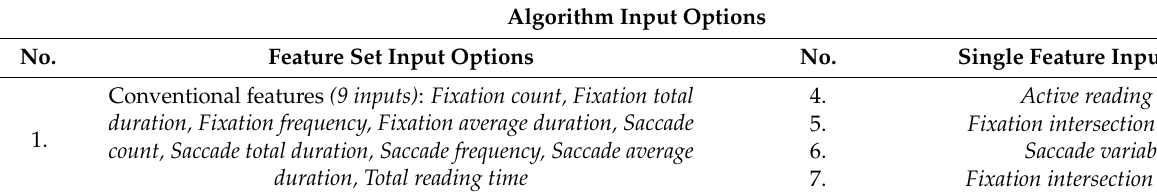
Table 1. ML algorithm input feature options. Algorithm Input